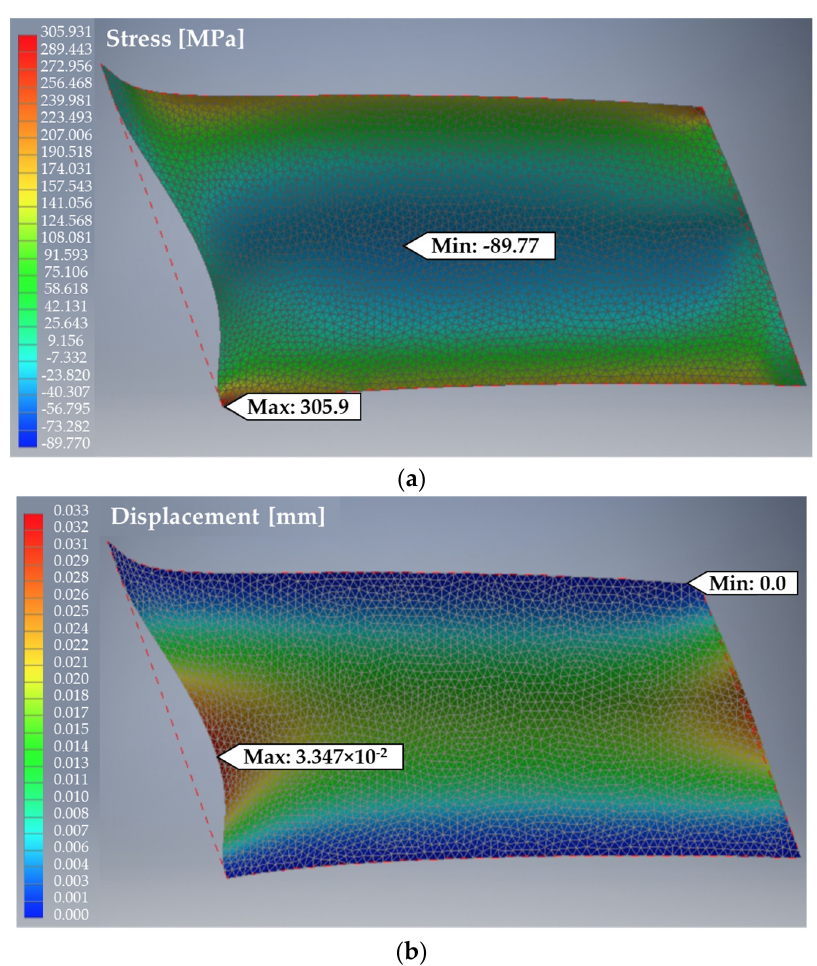
Figure 9. FEA output for a single blade of the proposed impeller made of AISI 316L stainless steel sheet to be printed through SLM: ( a ) stress distribution (the maximum stress is on the bottom left corner); ( b ) total displacement. Table 7. Main FEA results for the three materials adopted (i.e., AISI 304 from the original impeller, PET for the concept model to be printed with the FDM technique, and AISI 316L for the functional model to be printed with the SLM technique).